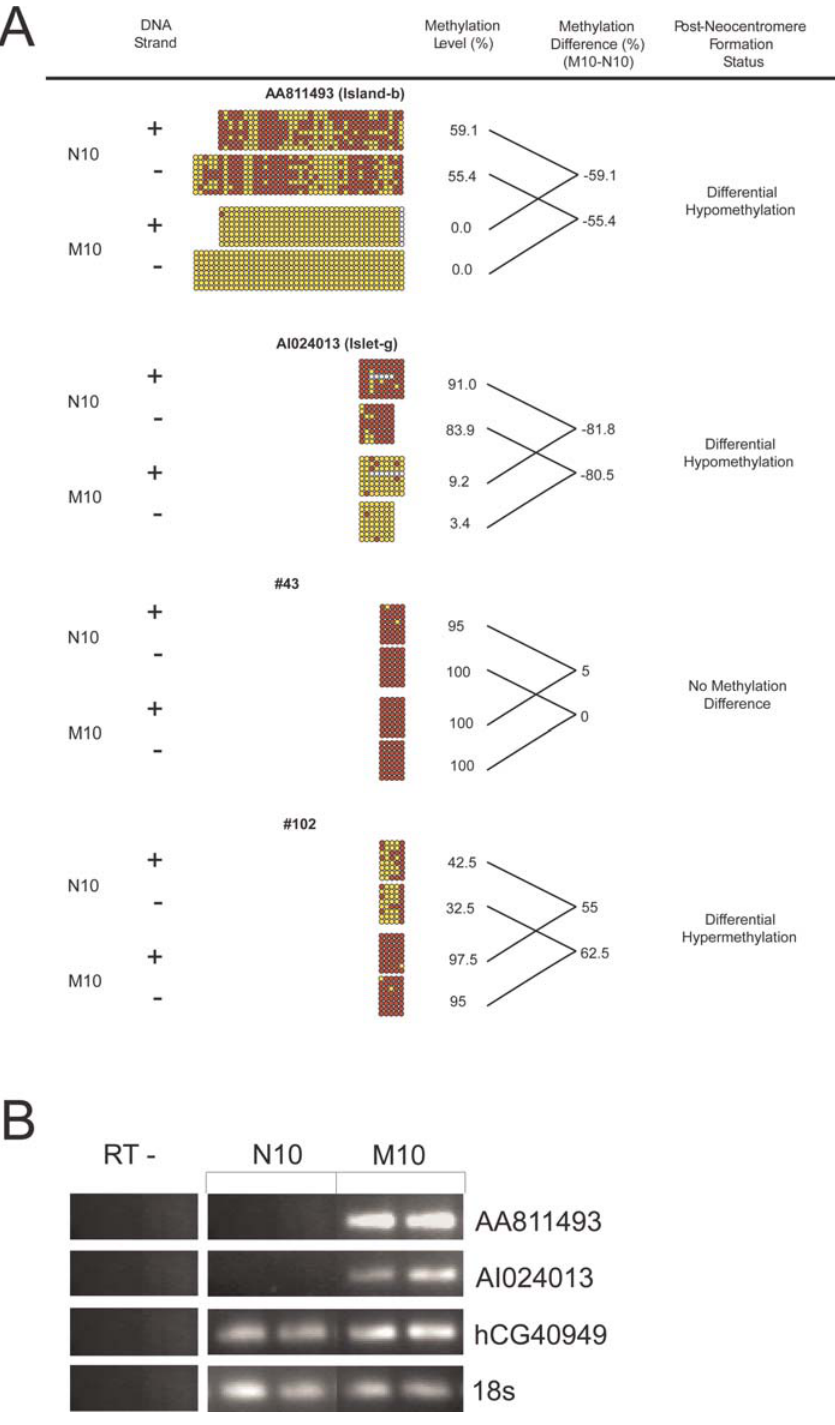
Figure 5. DNA Strand-Bias